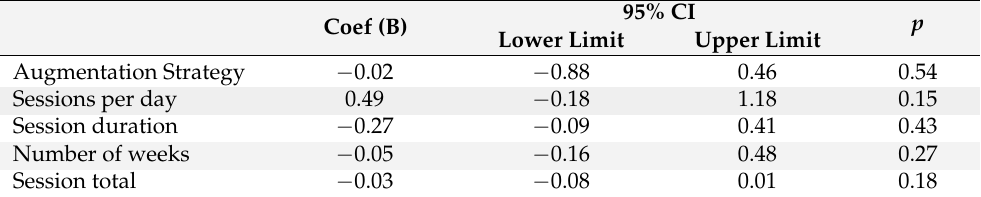
Table 2. Results of univariate meta-regression analyses.